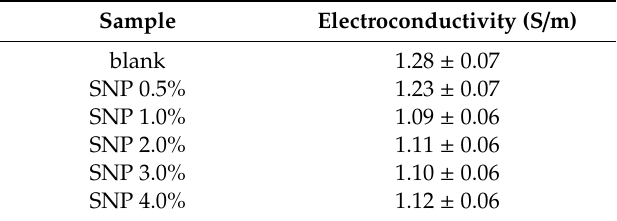
Table 1. The electroconductivity of ionogels composites.